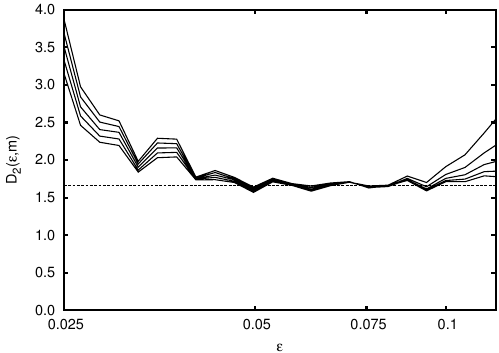
Figure 5. The local slopes D 2 ((cid:15),m) for the wind speed time series Fig. 5. The local slopes D 2 ( (cid:15),m ) for the wind speed time series with τ = 85 and m ranging from 14 to 16 showing a plateau for with τ = 85 and m ranging from 14 to 16 showing a plateau for small values of (cid:15) and giving an estimate of D 2 =1 . 656 small values of (cid:15) and giving an estimate of D 2 = 1 . 656 ± 0 .